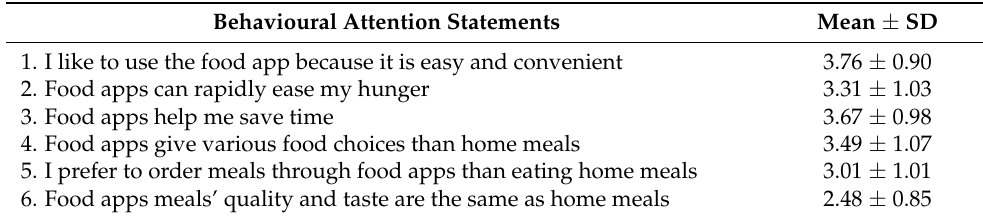
Table 2. Mean score of the behavioural attention constructs ( n =